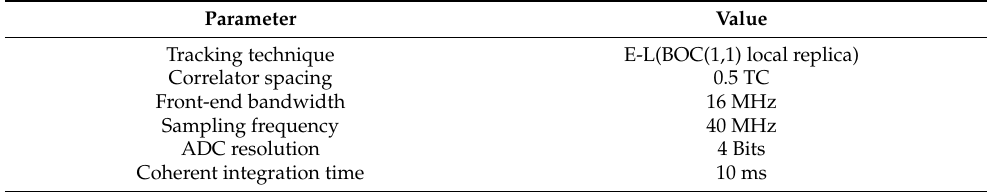
Table 1. The parameters of the receiver.